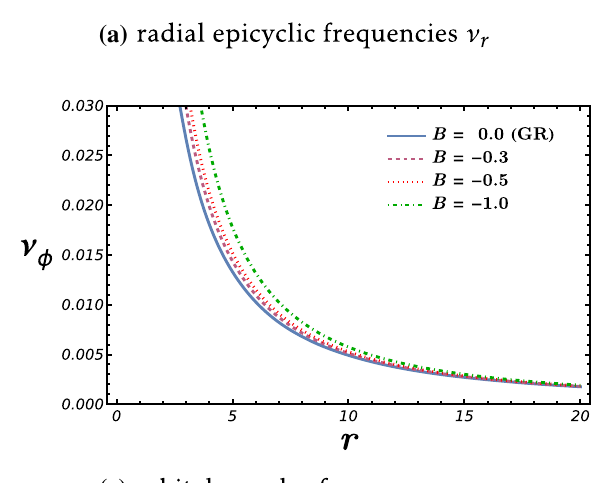
set to 0.0, − 0.3, − 0.5, − 1.0 in a – c . In d B = 0 and − 1.0 for bottom and top curves respectively for ν ϕ and ν θ , while for top and bottom curves for ν